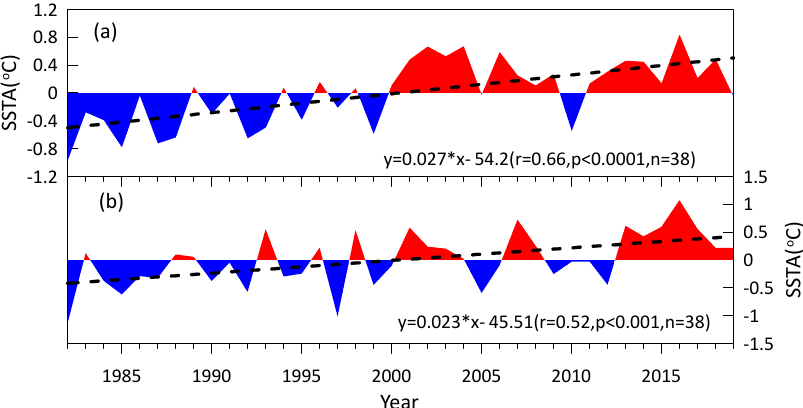
Figure 8. Relationship between upwelling intensity (R) and SSTA for the coastal upwelling system of the Taiwan Strait.